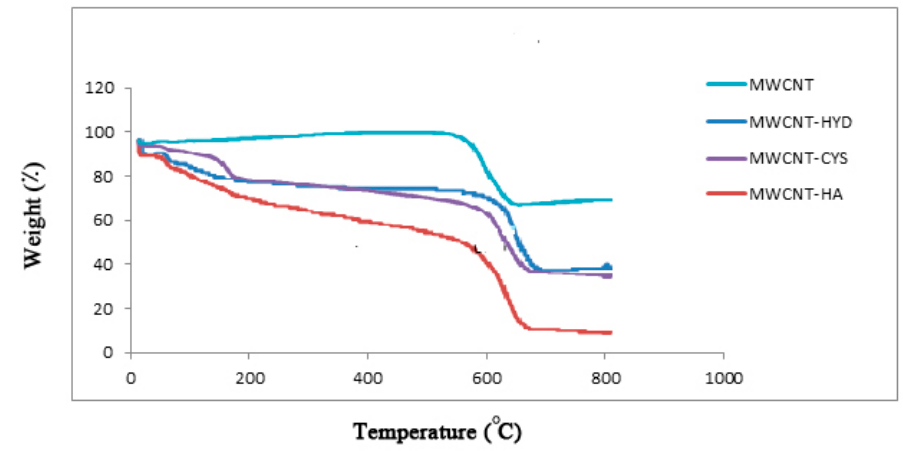
Figure 6. TGA analysis for MWCNT, m-MWCNT–HA, m-MWCNT–CYS, and m-MWCNT–HYD.